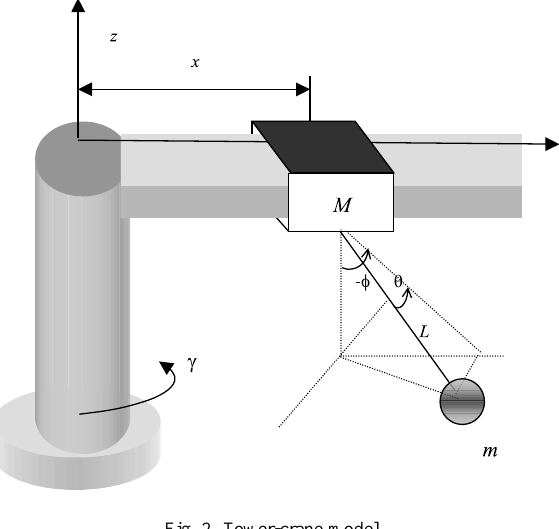
Fig. 2. Tower-crane